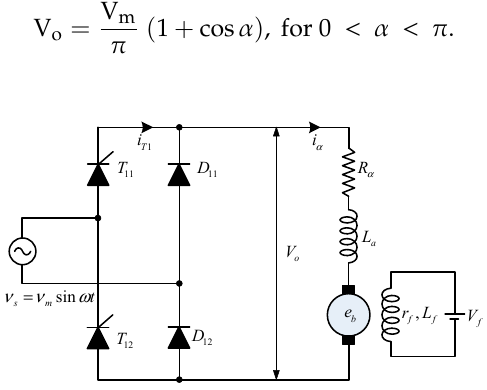
Figure 4. Single-phase half wave converter drive.